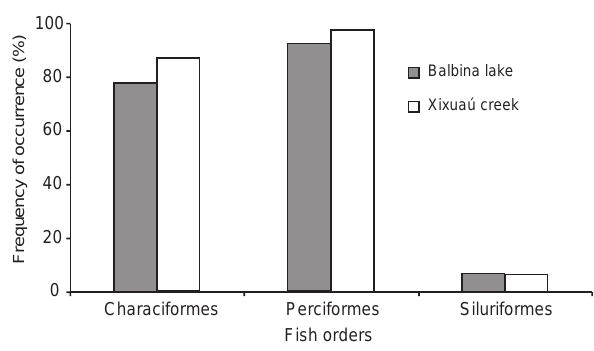
Figure 2. Frequency of occurrence of fish orders found in feces samples of giant otters from Balbina hydroelectric reservoir (N = 254 samples) (present study), and in an area without hydroelectric plant influence, Xixuaú creek, N = 37 samples (R OSAS et al. 1999).